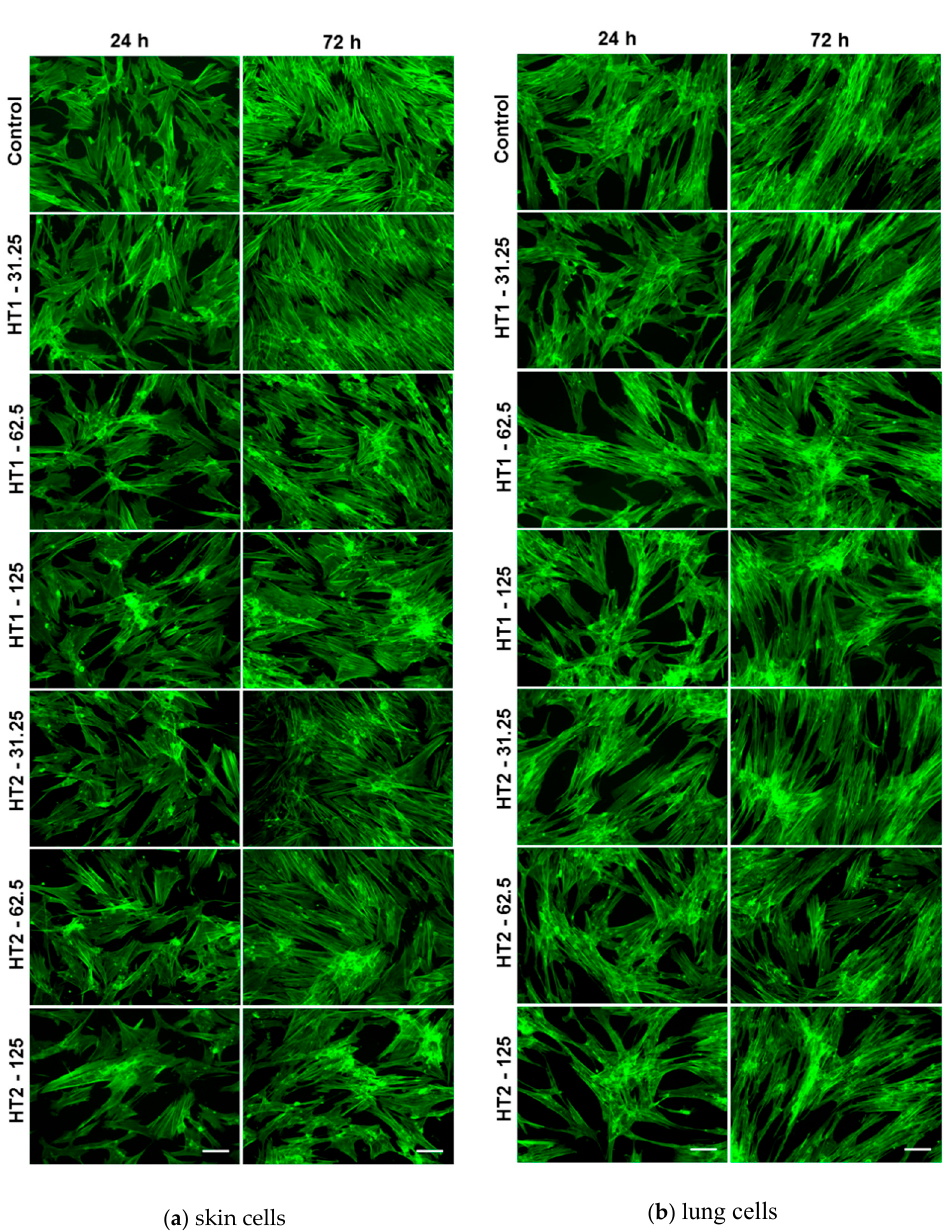
Figure 11. Actin cytoskeleton organization of skin ( a ); and lung ( b ) fibroblasts after 24 and 72 h of incubation with different concentrations ( µ g/mL) of the two TiO 2 NPs samples: TiO 2 -1% Fe–N co-precipitated at pH 8.5 (HT1) or pH 5.5 (HT2). F-actin (green) was labeled with phalloidin-fluorescein isothiocyanate (FITC). Scale bar: 100 µ